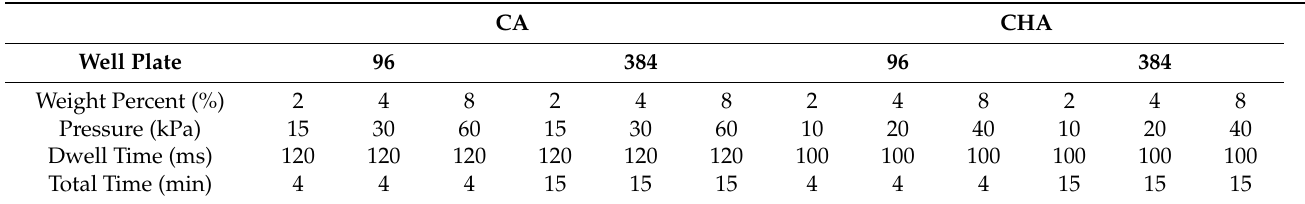
Table 1. Parameters used for automated casting of CA and CHA scaffold material.